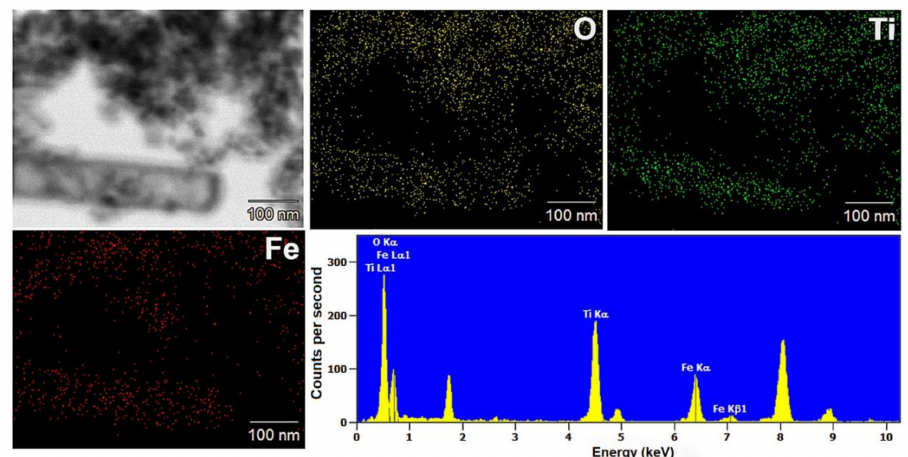
Figure 2. Results of EDS mapping for the (7)TiO 2 -(3)Fe 3 O 4 composite.